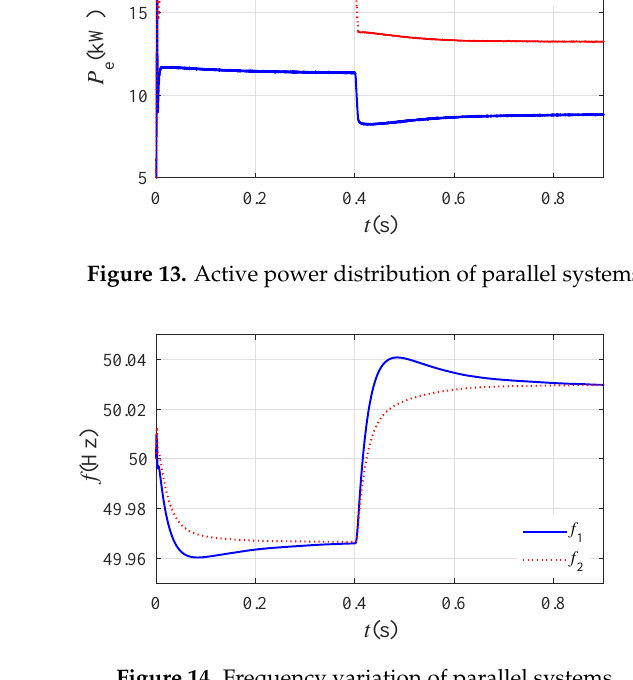
Figure 14. Frequency variation of parallel